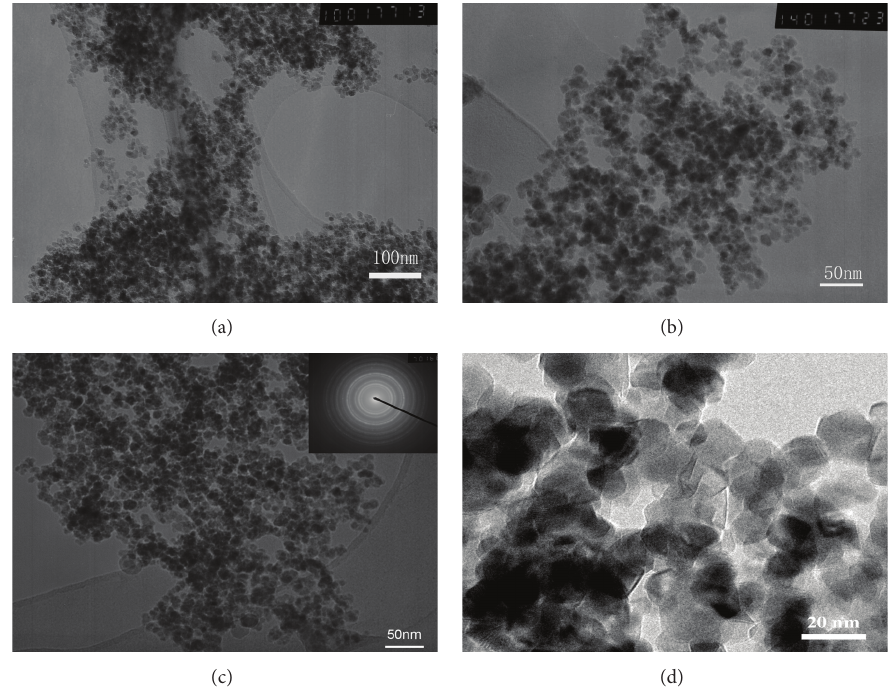
Figure 2: (a) TEM images of Fe 3 O 4 . (b) TEM images of SF. (c) TEM images of TSF. (d) HRTEM images of TSF. The inset in (c) is the electronic diffraction of TSF.